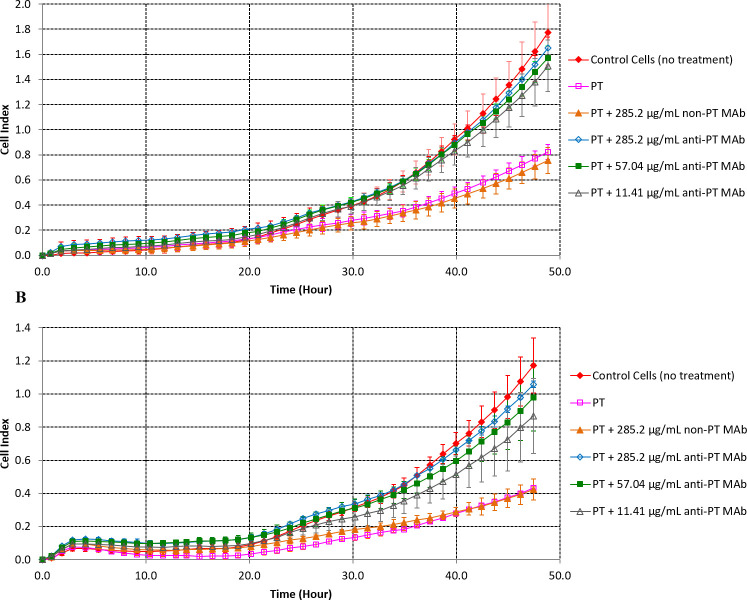
Cell index in real time after treatment of CHO cells with pertussis toxin alone or preincubated with anti-pertussis toxin or irrelevant non-PT antibodies.(A) Standard pertussis toxin (1 IU/mL = 6.7 ng/mL), average of 2 or more replicates are shown for each condition. (B) In-house pertussis toxin (6.8 ng/mL), average of 3 or more replicates are shown for each condition. Antibodies were serially diluted to PT to antibody molar ratios of 1 to 30000 (285.2 μg/mL), 1 to 6000 (57.0 μg/mL) and 1 to 1000 (11.4 μg/mL). Error bars represent standard deviations.